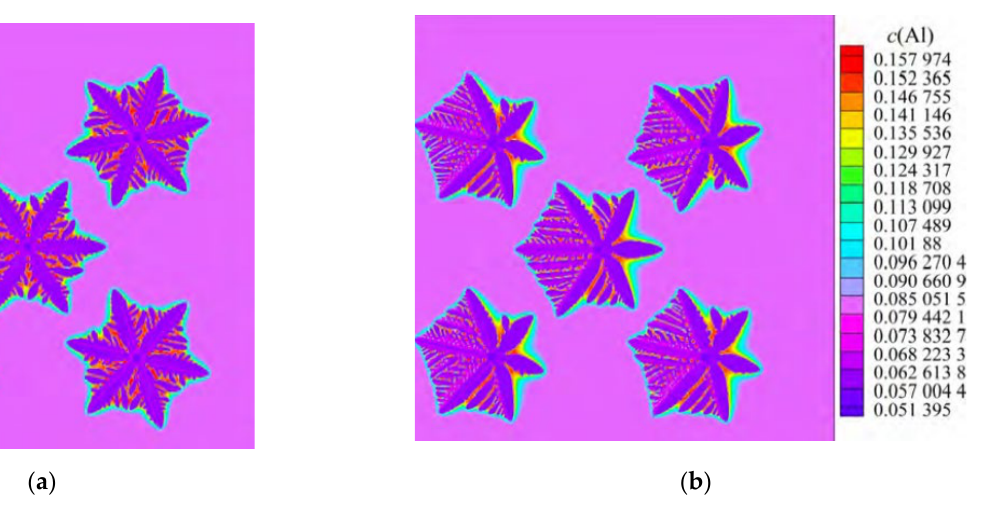
Figure 4. Distributions of solute for multiple grains growth: ( a ) without forced convection, and ( b ) with forced convection [81].